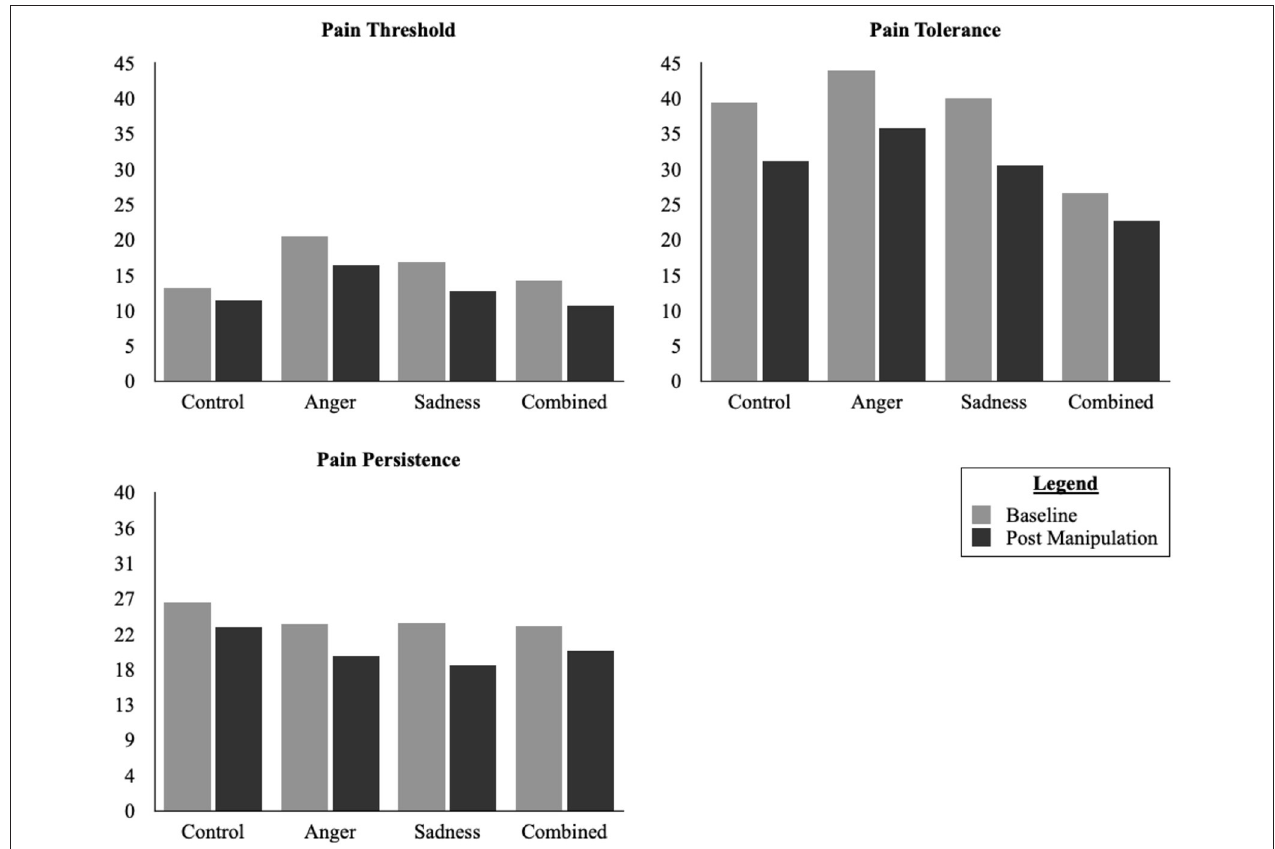
FIGURE 1 | Changes in pain responses in Study